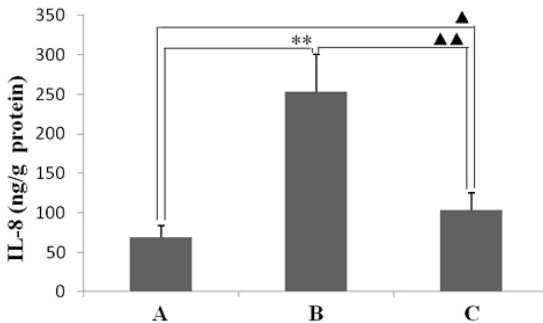
Figure 6. The effect of IL-8 protein levels in gastric mucosal tissues with resveratrol treatment, as measured by ELISA. (A) Normal control animals; (B) H. pylori -infected model animals without resveratrol treatment; and (C) H. pylori -infected animals with resveratrol treatment. ** p < 0.01 versus normal animals; ▲▲ p < 0.01 versus model animals; ▲ p < 0.05 versus normal animals ( n = 10).